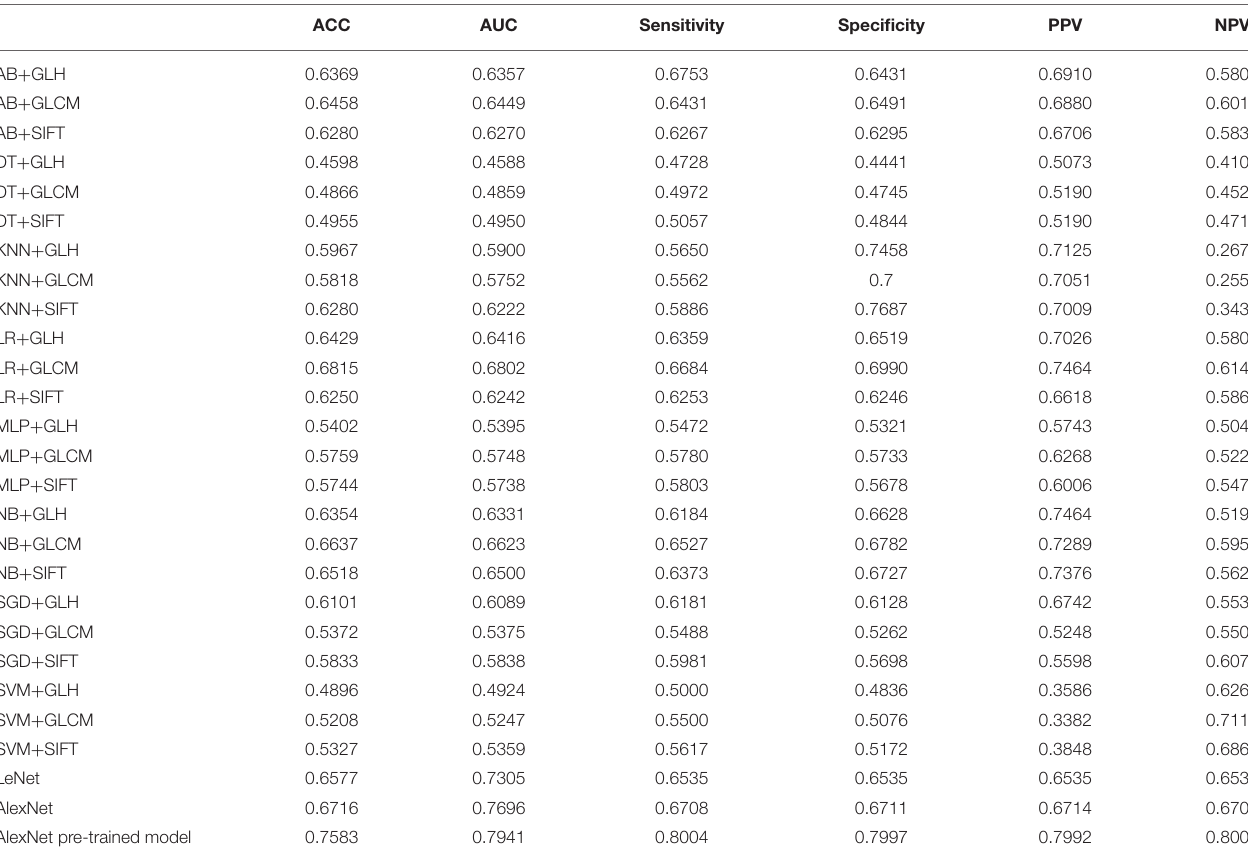
TABLE 1 | Performance results of all methods for CRC